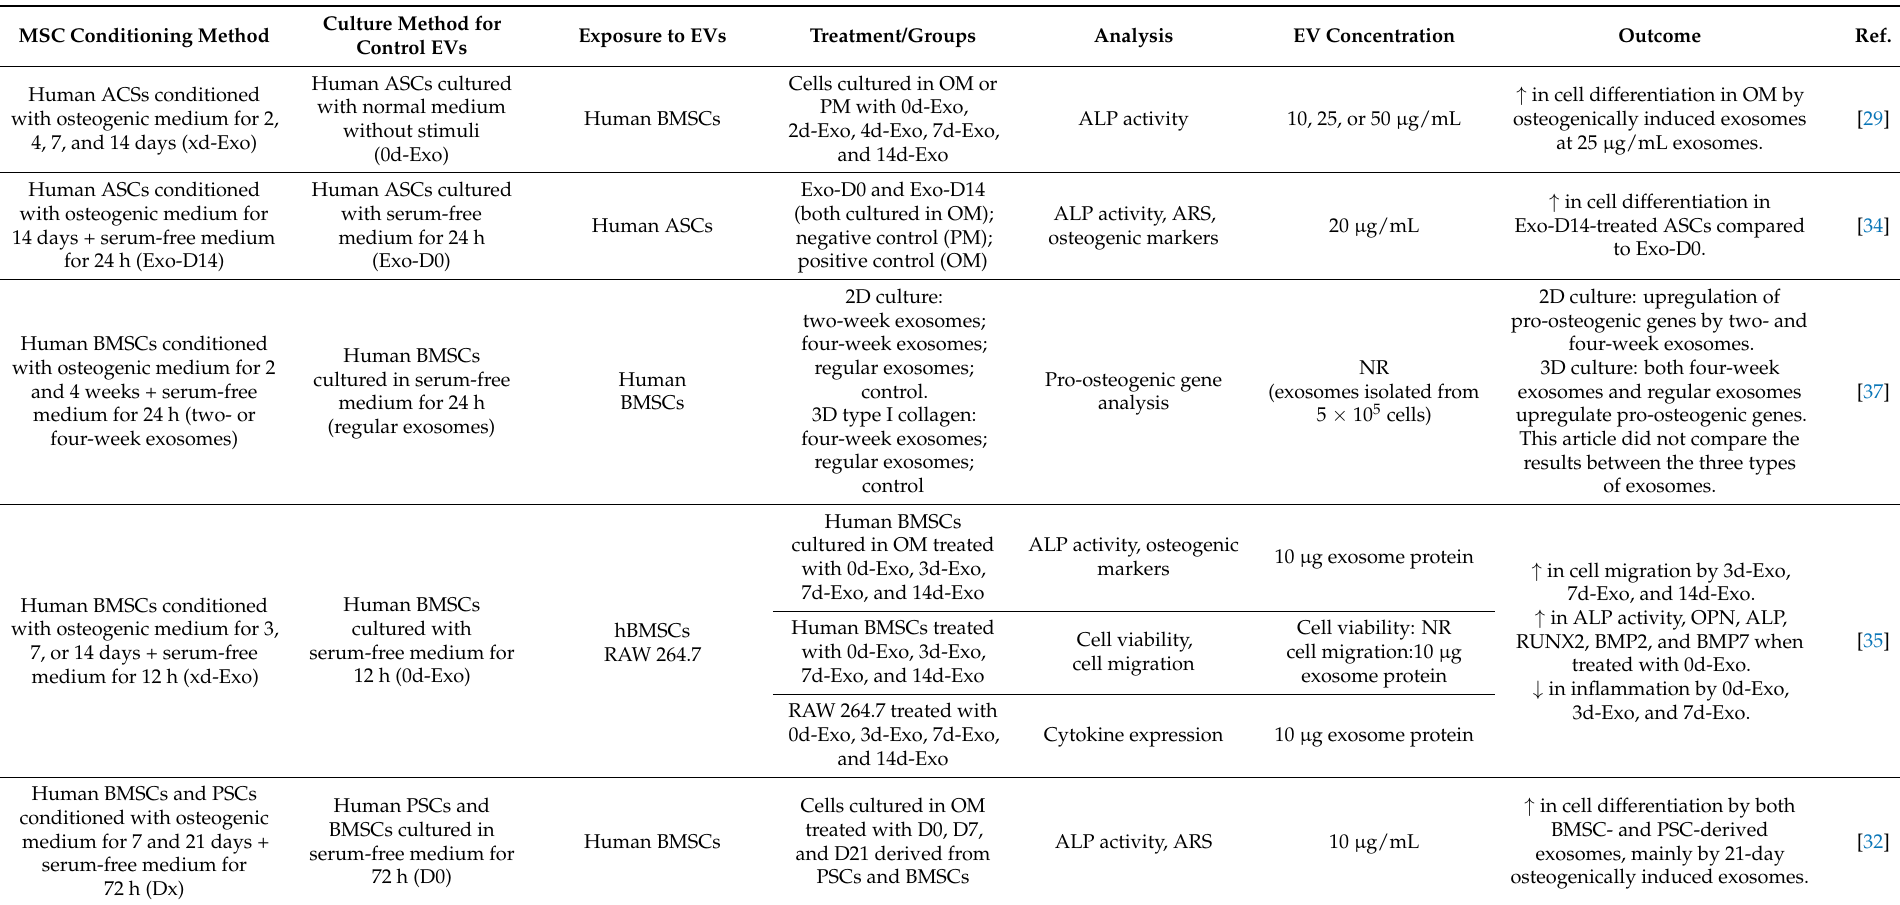
Table 3. Summary of in vitro methods and